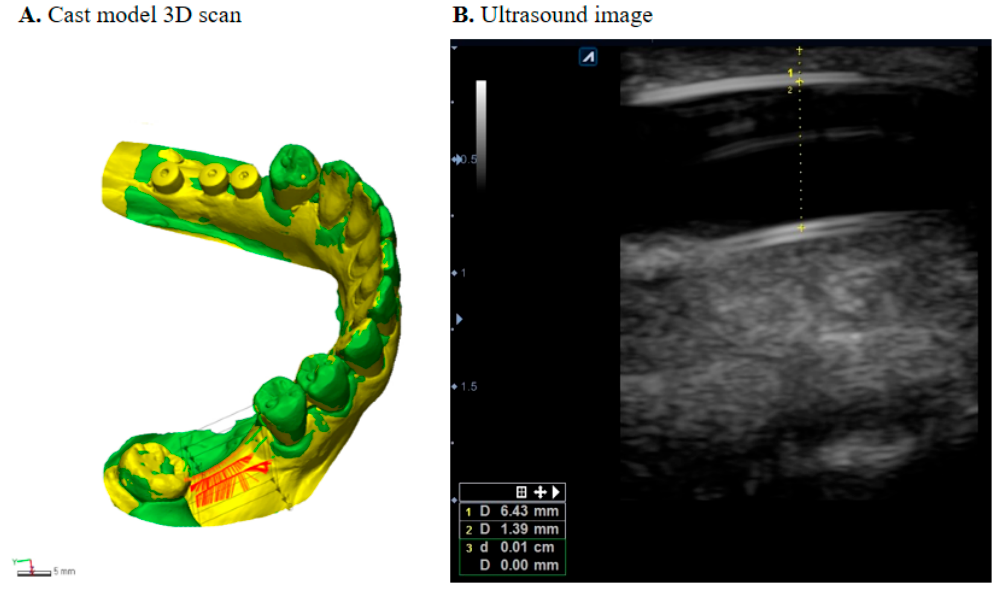
Figure 3. ( A ) Superimposition analysis for the measurement of soft tissue changes. ( B ) Ultrasonographic measurement of gingival